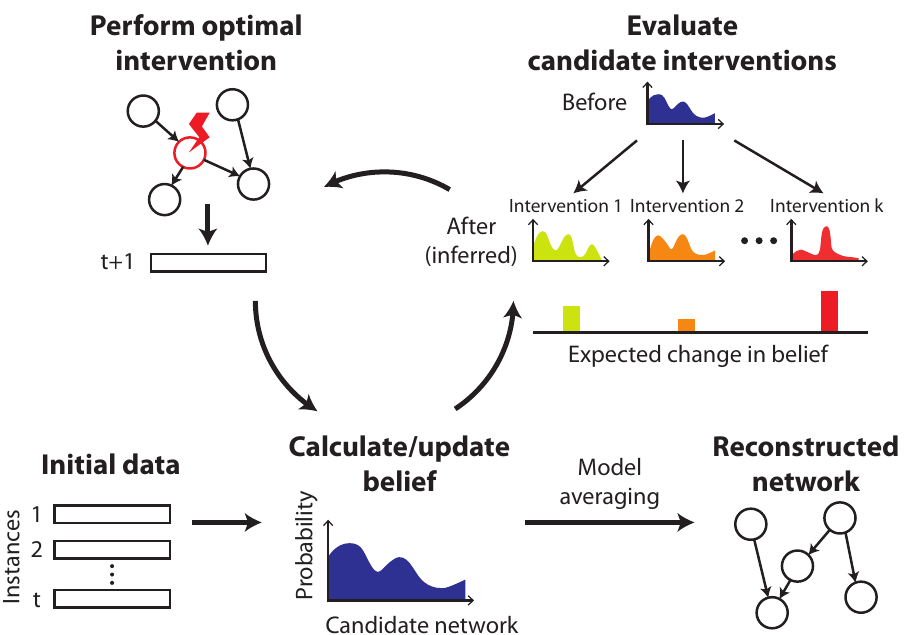
Fig 1. Active learning framework for network reconstruction. We first estimate our belief over candidate graph structures based on the initial data set that contains observational and/or intervention samples. Then, we iteratively acquire new data instances by carrying out the optimal intervention experiment predicted to cause the largest change in our belief (in expectation) and updating the belief. The final belief is summarized into a predicted network via Bayesian model